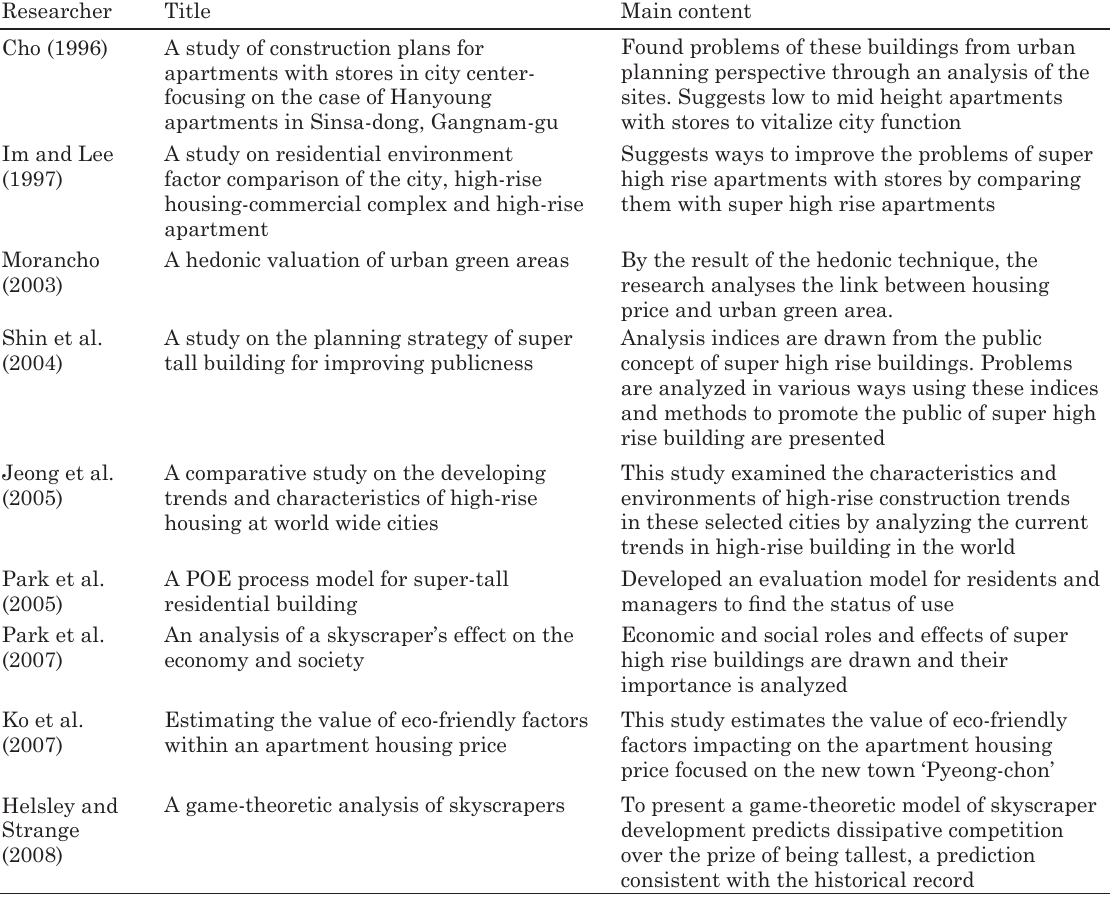
table 1. previous studies of super high rise buildings and hedonic model